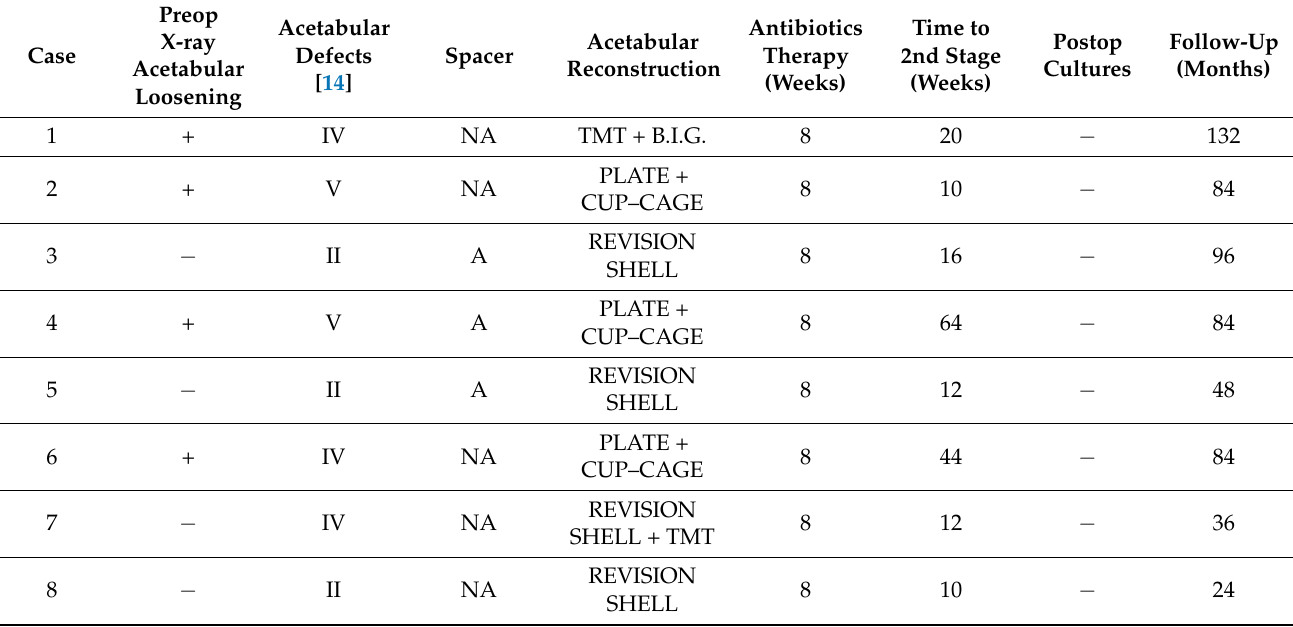
Table 3. Intraoperative and postoperative features. NA: non-articulated; A: articulated; B.I.G: bone impaction